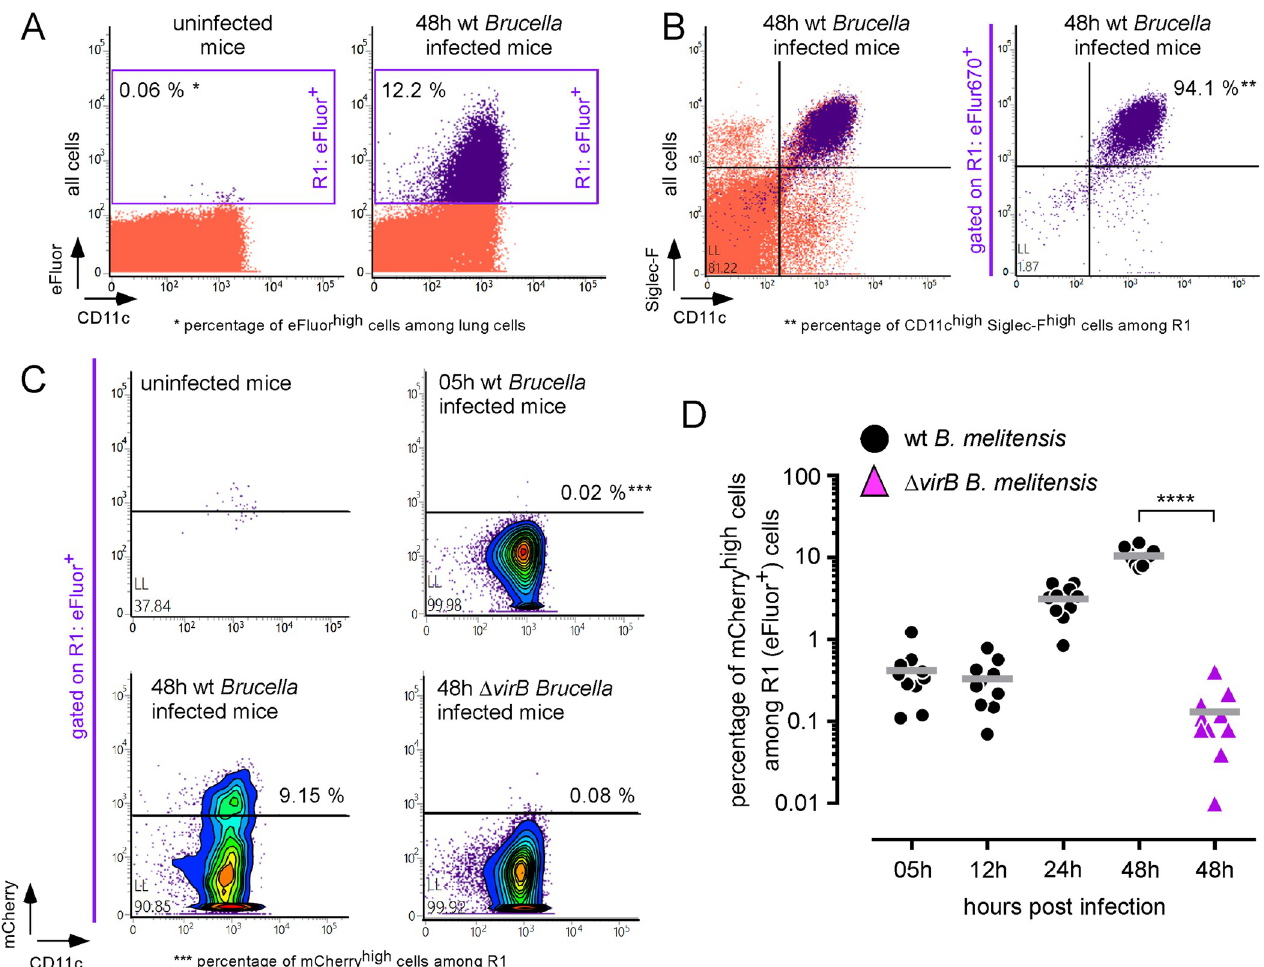
Fig 4. B . melitensis multiplies exponentially only in a fraction of alveolar macrophages. C57BL/6 mice (n = 10) received intranasally PBS (uninfected mice) or 5x10 6 CFU of mCherry-expressing wild-type or Δ virB strains of B . melitensis labelled with eFluor 670 . Mice were sacrificed at the indicated time. Lungs were collected and analyzed individually by flow cytometry for the expression of CD11c, Siglec-F, mCherry and eFluor 670 . Data shown are ( A ) representative dot plots of total lung cells from control and infected mice analyzed for the expression of CD11c and eFluor 670 , ( B ) representative dot plots of total lung cells and eFluor + cells (R1 gate) analyzed for the expression of CD11c and Siglec-F, ( C ) representative dot plot of eFluor + cells analyzed for the expression of CD11c and mCherry, ( D ) the kinetic percentage of mCherry high cells among eFluor + lung cells per individual mice (n = 10). These results are representative of three independent